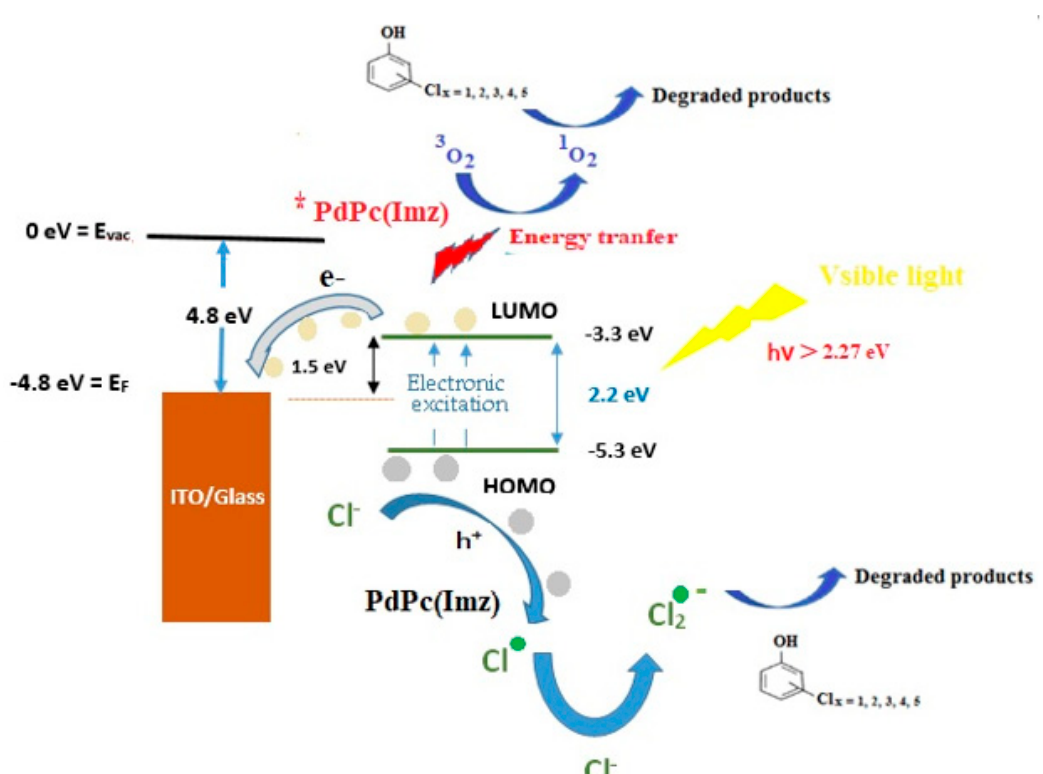
Figure 6. Schematic of electron-hole pairs separation at the interface of PdPc(Imz) films deposited on glass substrate under visible light irradiation in artificial